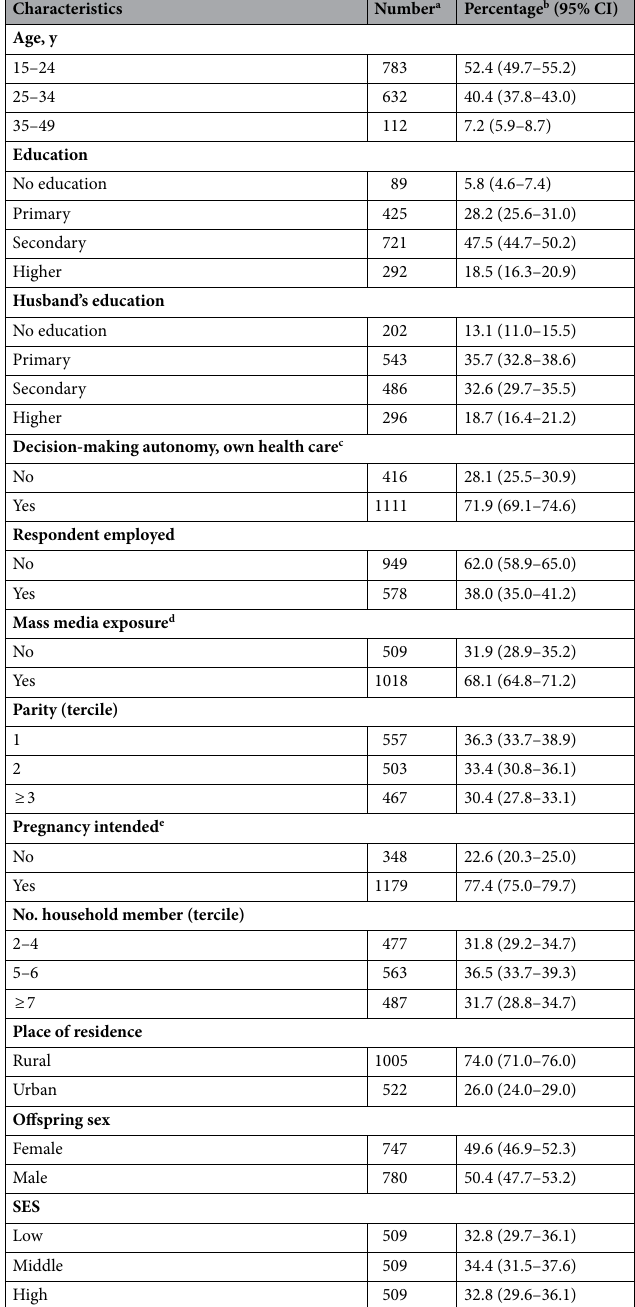
Table 1. Characteristics of the study population: Bangladesh Demographic and Health Survey 2017–18 (n = 1527). CI = confidence interval. a Numbers are unweighted; b Percentages are weighted; c women participated alone or jointly in the decision making on own health care; d watching television, listening to the radio, or reading the newspaper at least once a week; e Intended: live birth wanted at time of conception or unintended: live birth wanted after conception or not wanted at